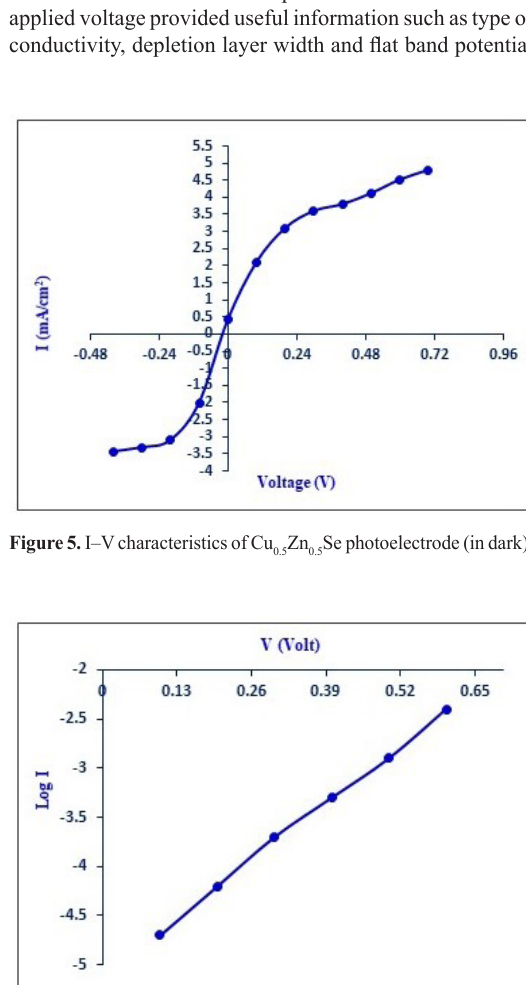
Figure 6. Determination of junction ideality factor of Cu